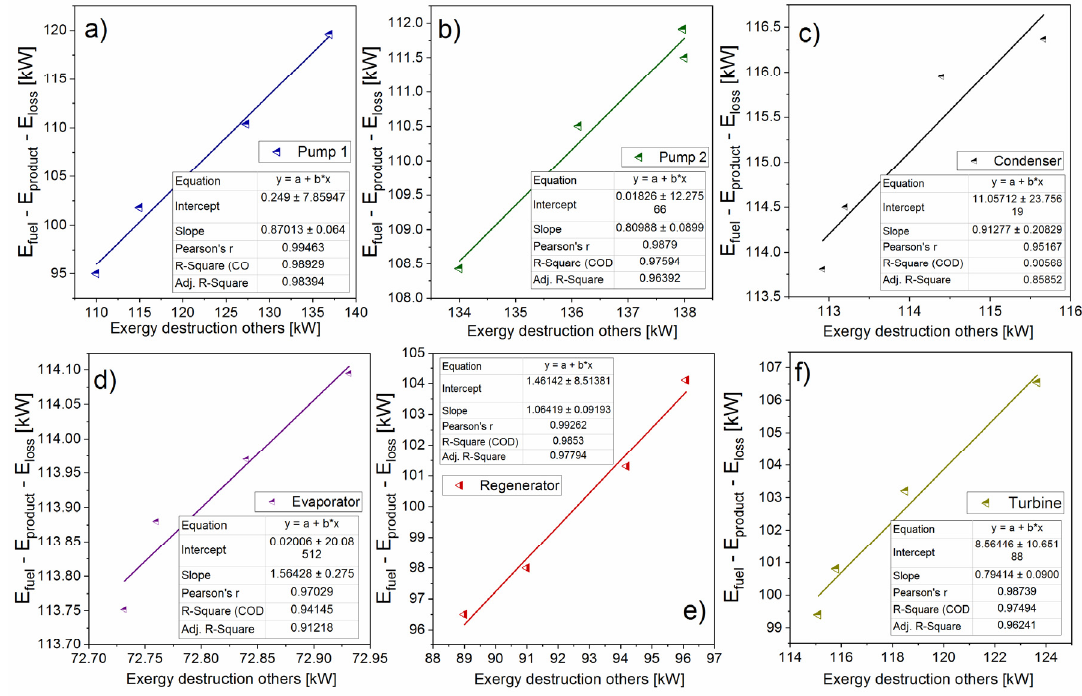
Figure A2. Endogenous destruction of exergy for toluene ( a ) Pump 1, ( b ) Pump 2, ( c ) condenser, ( d ) evaporator, ( e ) regenerator, and ( f ) turbine.